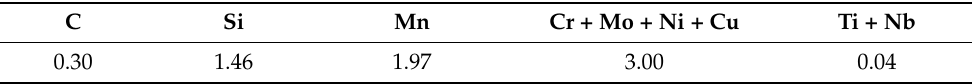
Table 1. Chemical composition of the investigated steel